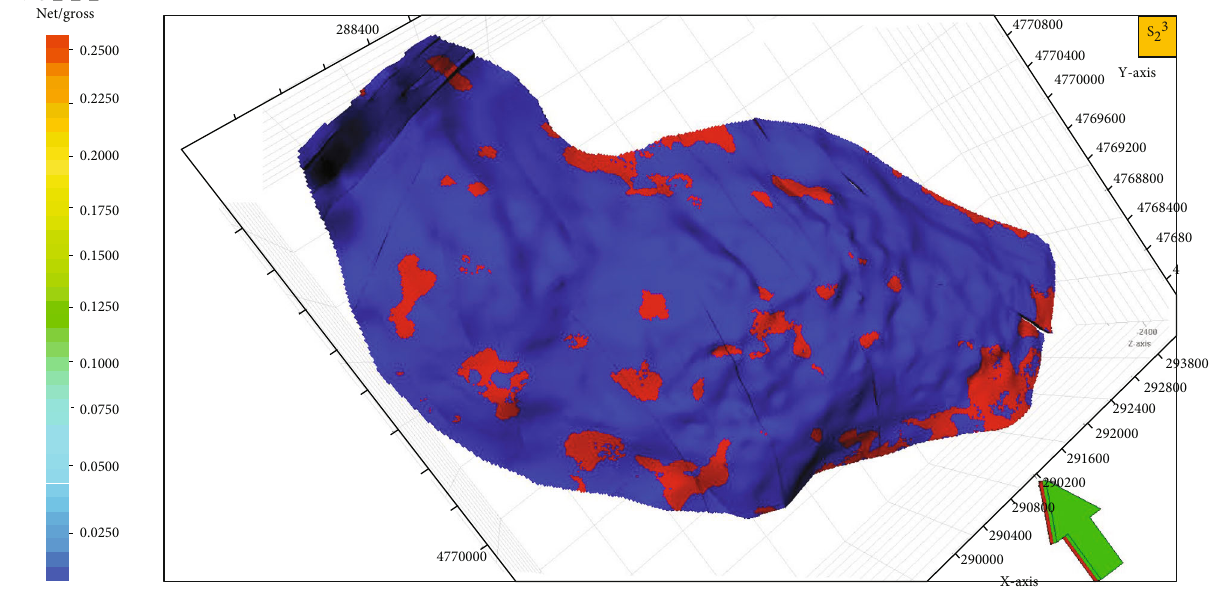
Figure 19: The NTG model of S 3 :